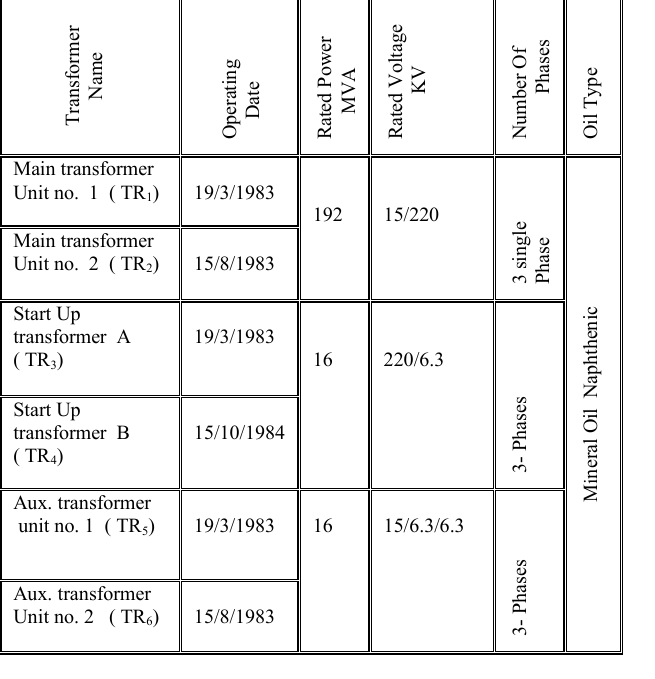
TABLE III. RATING OF POWER TRANSFORMER UNDER TESTING